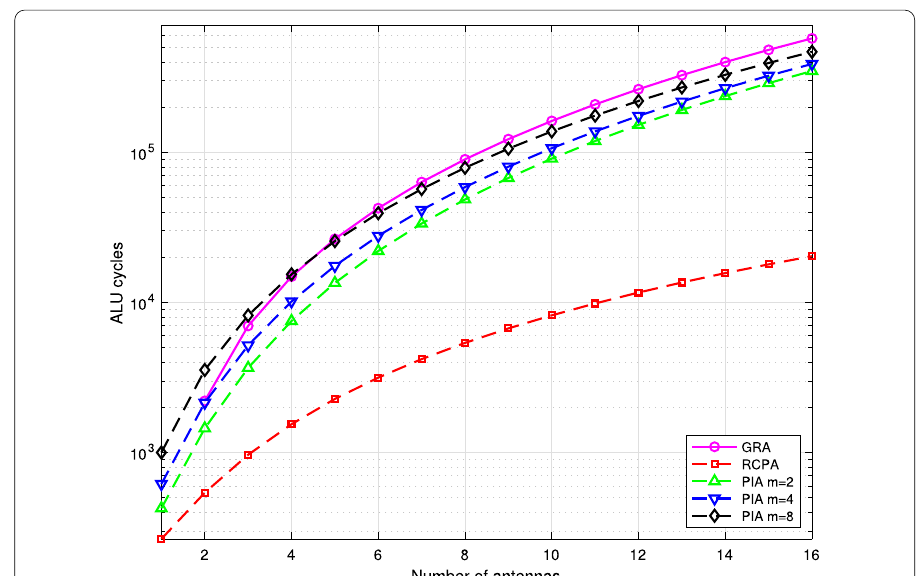
Fig. 3 ALU cycles needed to perform the Golub–Reinsch algorithm (GRA), the power iteration algorithm 2,4 and 8 iterations and the reduced-complexity power algorithm (RCPA) for MIMO channels (PIA) with m = with equal number of transmit and receive